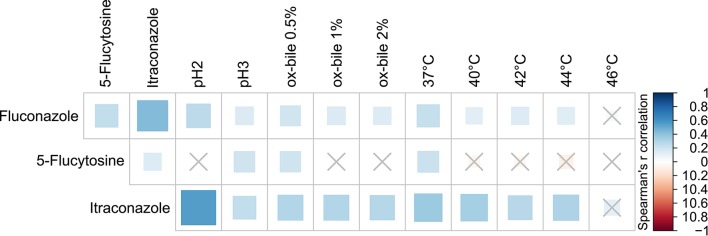
Spearman's r correlation analysis between antifungals susceptibility and growth ability of the tested fungal isolates under different stress conditions. Solid squares represent the degree of correlation among the variables taken into account. Crossed squares indicate non-significant correlations; significant results with p < 0.05.